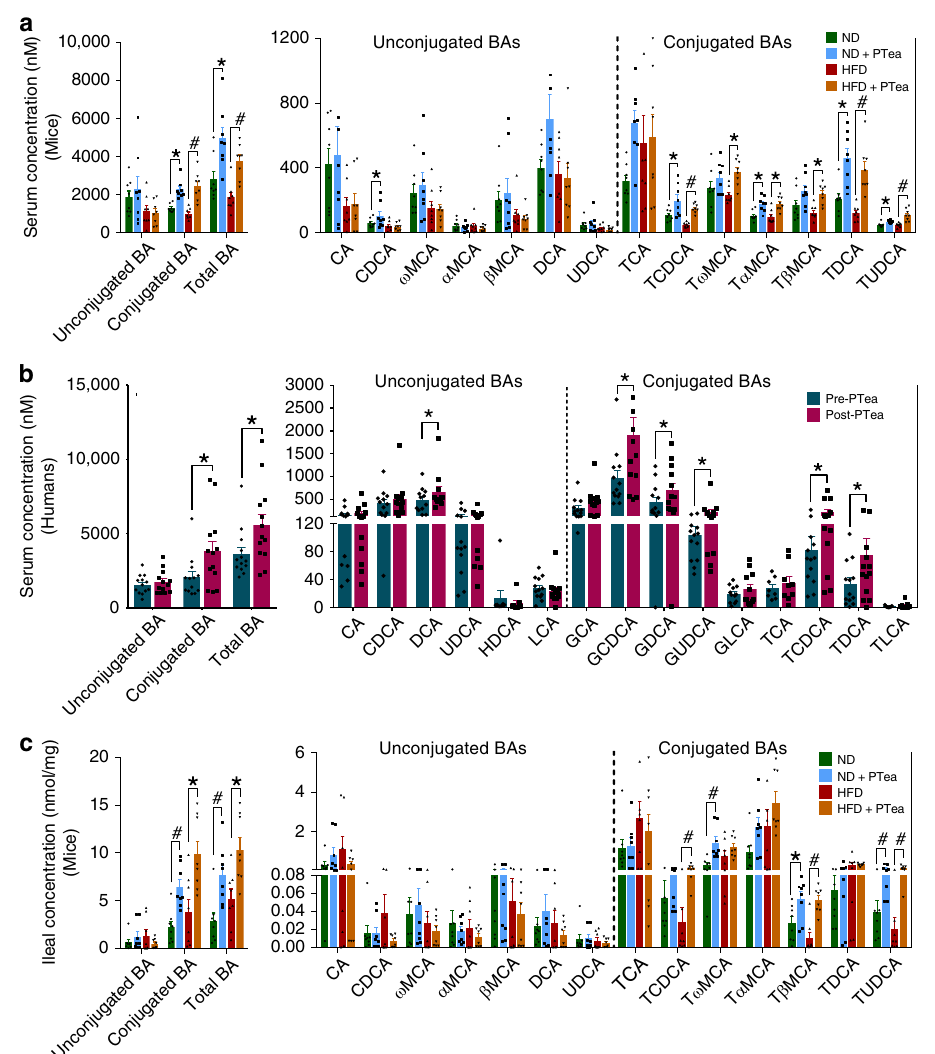
Fig. 4 Pu-erh tea elevated conjugated BAs in serum and ileum. a Serum BA classes and BA pro fi le of mice after 450 mg/Kg/day Pu-erh tea consumption for 26 weeks. n = 8 individuals/group. b Serum BA classes and BA pro fi le of human subjects after 50 mg/Kg/day Pu-erh tea consumption for 4 weeks. n = 13 individuals/group. c Ileal BA classes and BA pro fi le of mice after 450 mg/Kg/day Pu-erh tea consumption for 26 weeks. n = 8 individuals/group. Data were expressed as mean ± SEM. Differences of data for mice and human subjects were assessed using the Mann – Whitney U test and Wilcoxon rank- sum test, respectively, * p < 0.05, # p <